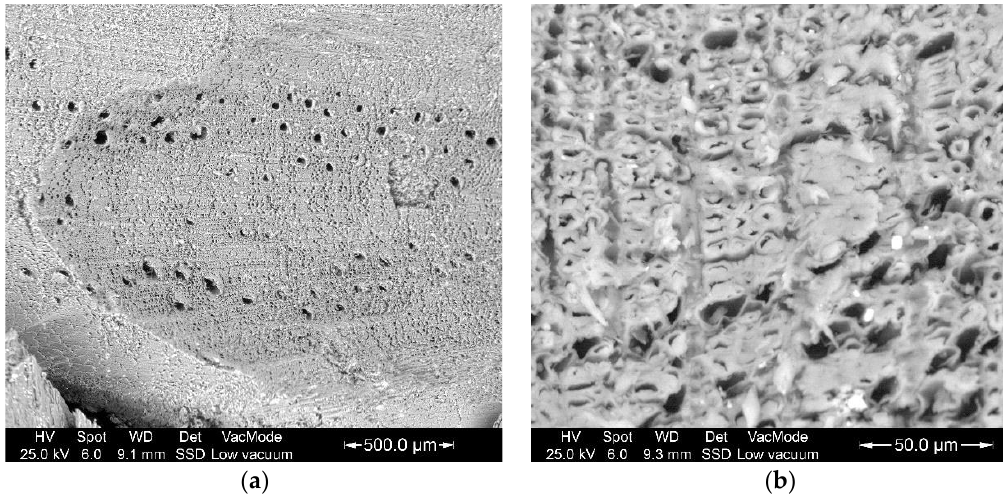
Figure 8. Electron micrographs of the cut footprint made by the insect in a cross section of holm oak